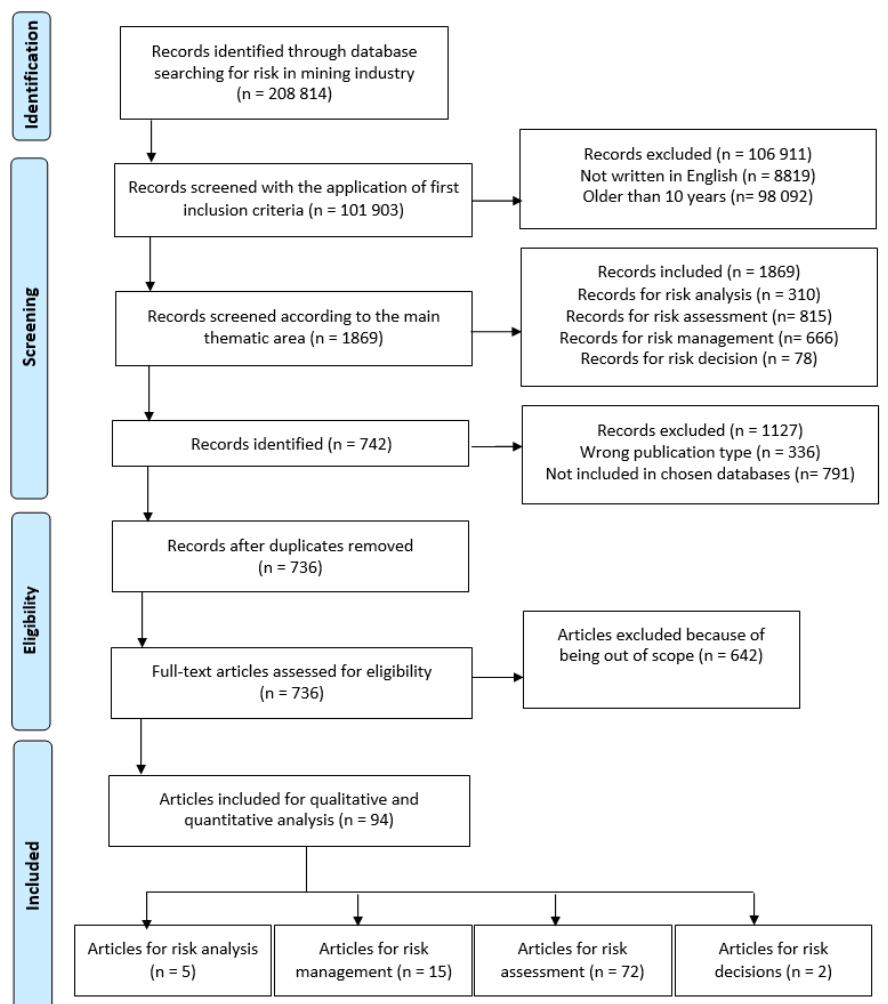
Figure 3. Preferred Reporting Items for Systematic Reviews and Meta-Analyses (PRISMA)-based flowchart of the systematic selection of the relevant studies in the analyzed research area.